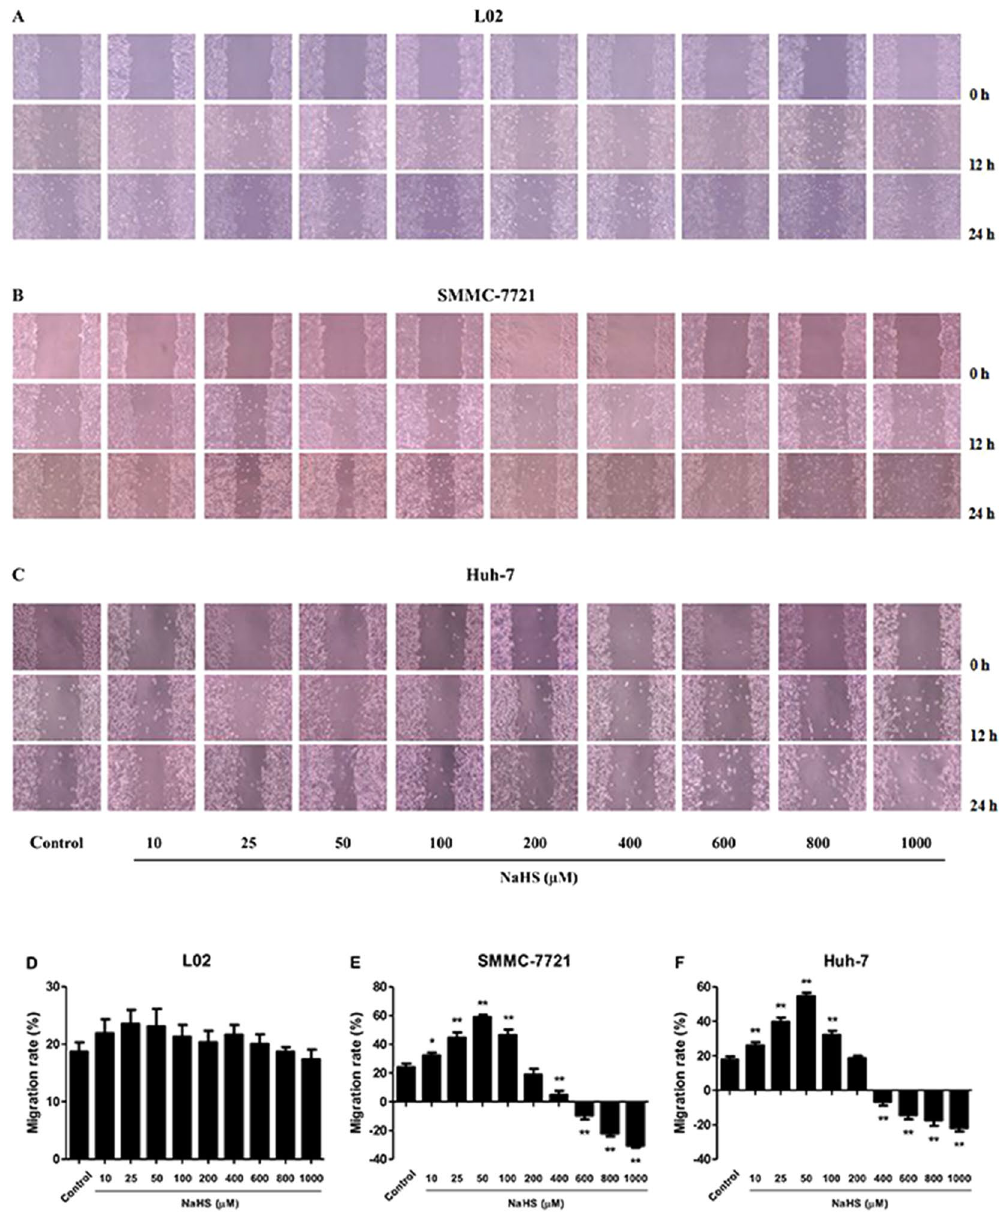
Figure 3. Effect of H 2 S on the mobility of human normal hepatocytes and HCC cells. ( A – C ) The human normal hepatocyte cell line L02 and HCC cell lines SMMC-7721 and Huh-7 were seeded into 6-well plates at 2 × 10 5 cells/ well. After incubation with NaHS at 0 (Control), 10, 25, 50, 100, 200, 400, 600, 800, and 1000 μ M for 24 h, the effect of H 2 S on cell migration was measured by wound-healing assay; original magnification 40x. ( D – F ) The migration rates of L02, SMMC-7721, and Huh-7 cells were calculated by the formula shown above. Data are presented as mean ± SEM of three independent experiments; * P < 0.05, ** P < 0.01 compared with the control